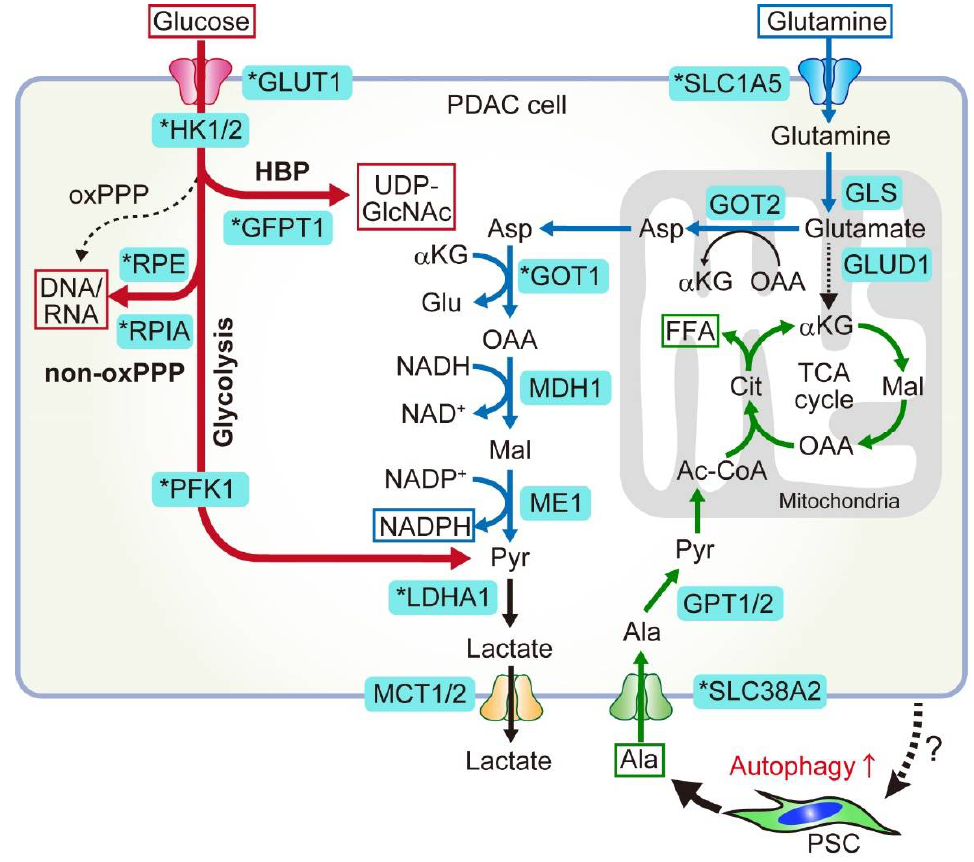
Figure 1. Central carbon metabolism in pancreatic ductal adenocarcinoma (PDAC) is rewired in a cell-autonomous manner by oncogenic KRAS signaling and in a cell-extrinsic manner via interaction with host stromal cells. Key enzymes that are upregulated by oncogenic KRAS are indicated with an asterisk. (Glucose metabolism, shown in red) Glucose is preferentially used for anabolic processes (anabolic glucose metabolism) in PDAC. This is mediated by the upregulation of key enzymes involved in those processes. Glucose transporter 1 (GLUT1) upregulation increases the glucose uptake, which fuels glycolysis and branching anabolic pathways. These include the hexosamine biosynthesis pathway (HBP), which produces precursors for glycosylation, and the non-oxidative pentose phosphate pathway (non-oxPPP), which produces ribose for nucleotide biosynthesis. (Glutamine metabolism, shown in blue) Glutamine is a key substrate that is used to fuel the tricarboxylic